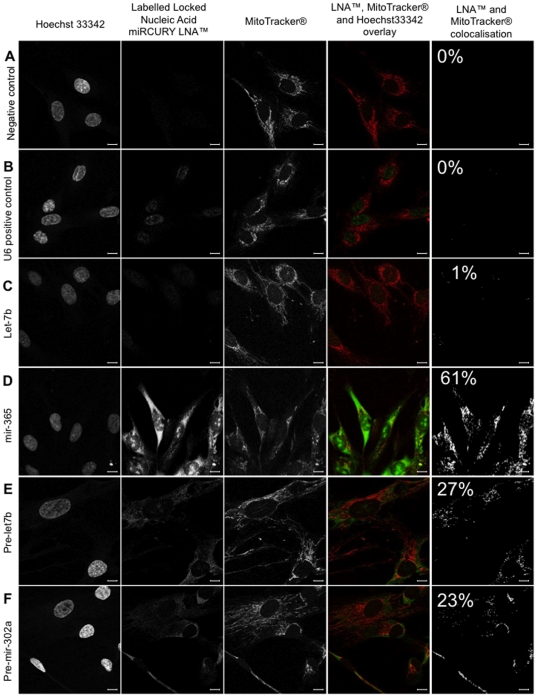
In situ signal of mir-365, pre-mir-let7b and pre-mir-302a co-localized with functioning mitochondria in human myoblasts observed in confocal microscopy.Using locked nucleic acid (LNA) probes, we performed in situ hybridization to localized mir-365, mir-let-7b, pre-let-7b and pre-mir-302a within the cell. Hoechst 33342 staining of nuclei (lane 1), specific signal of scramble miR (A; negative control), U6 small nuclear RNA (B; positive control), let-7b (C), mir-365 (D), pre-let-7b (E) and pre-mir-302a (F) provided by locked nucleic acid (LNA) probes (lane 2) and MitoTracker® Red CM-H2XRos staining of functioning mitochondria (lane 3) are represented in gray scale. All these images were acquired with a Leica TSC-P2 confocal microscope using a 63× oil-immersion objective. A sequential mode for three colour of acquisition (FITC for LNA probes signals, Dapi for Hoechst staining and Cy3 for MitoTracker® Red CM-H2XRos) has been used. In the overlays (lane 4) provided by Image J software, positive in situ hybridization signal are visualized in green and respiring mitochondria signal in red. Yellow corresponded to red and green overlay. The pixels with co-localized signals (lane 5) from functioning mitochondria and specific LNA probe for mir or pre-mir are determined using the Image J MBF plugging “co-localization highlighter”. Scale bars = 10 µm. The raw images are showed in the figure. The percentage of pixels with co-localized miRNA and mitochondrial signals were determined using Isodata plugging threshold (Image J software) and indicated on the figure (% in lane 5).